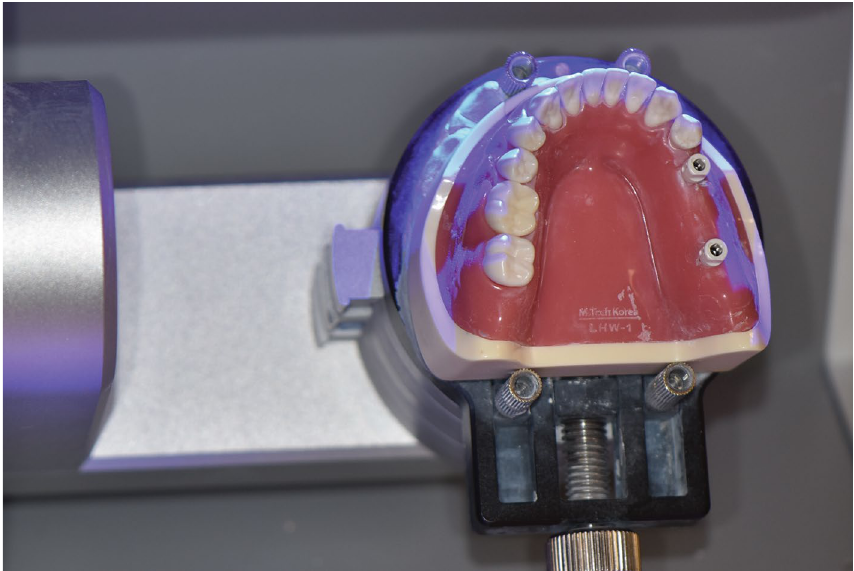
Figure 3. Creation of the reference scan data. Scanning of the models in each group with a desktop scanner (accuracy: 7 μm).